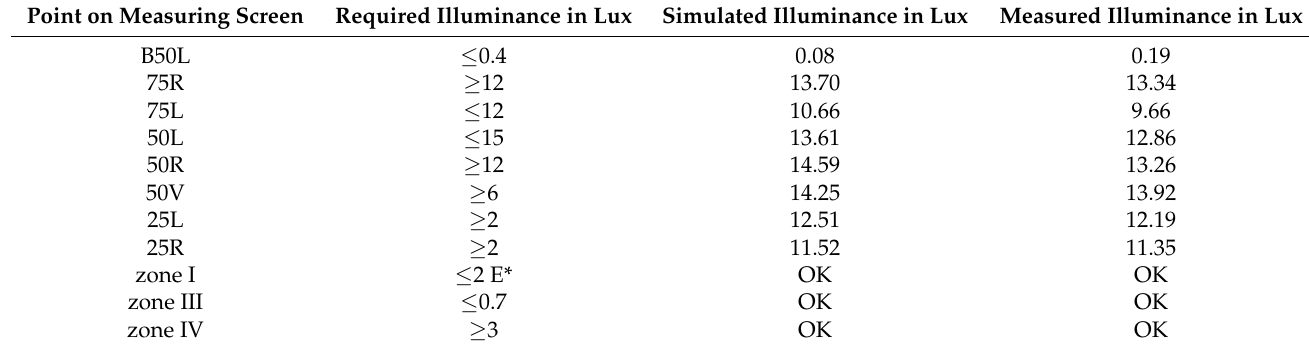
Table 2. Comparison of the simulated and measured illuminances of the LED headlamp with the corresponding values set by the ECE R112 regulation (Class B) for low-beam light.